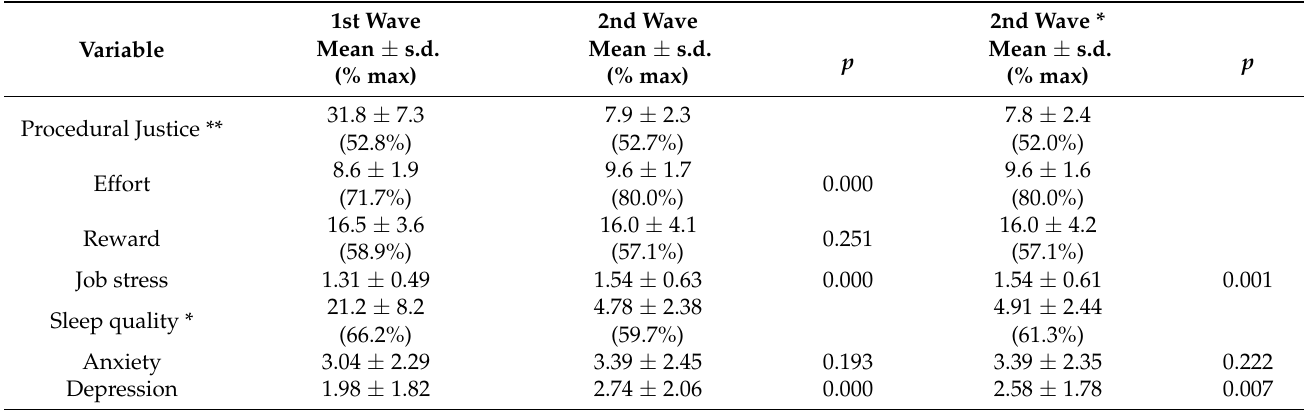
Table 3. Mental health indicators (perceived justice, occupational stress, sleep quality, anxiety, depression) in anesthesiolo- gists during the 1st and 2nd waves of the COVID-19